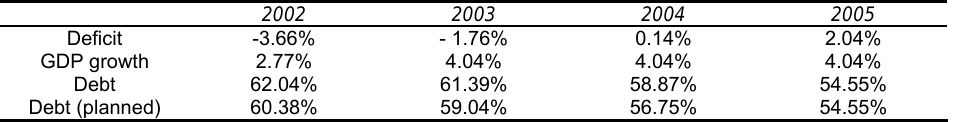
Table 6. German government deficit plan after a one-time deviation and revision